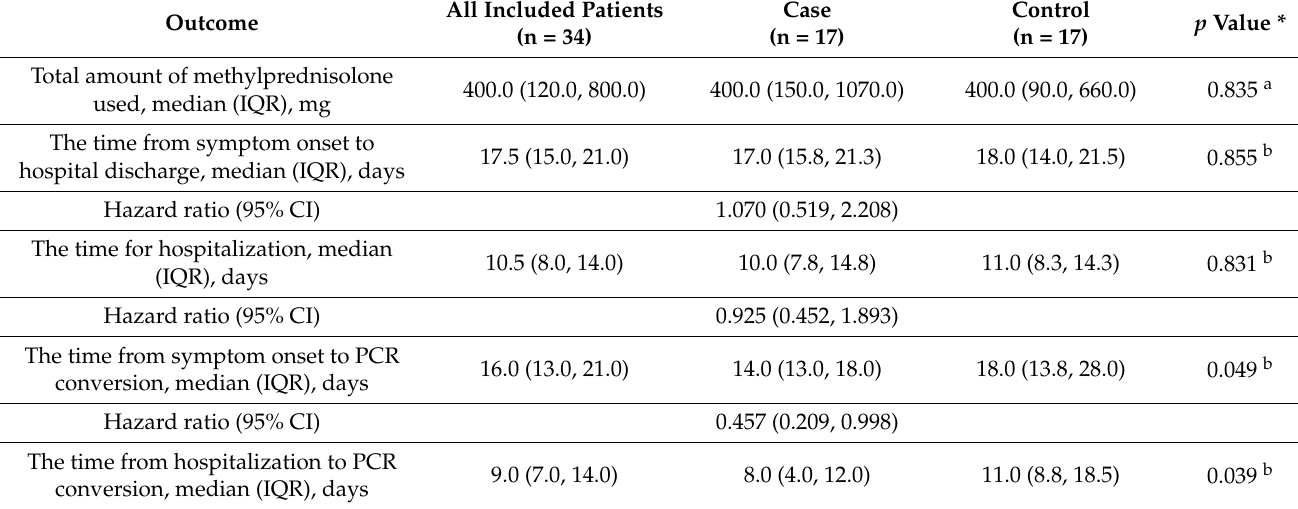
Table 2. Clinical outcomes of included cases and matched controls diagnosed as moderate